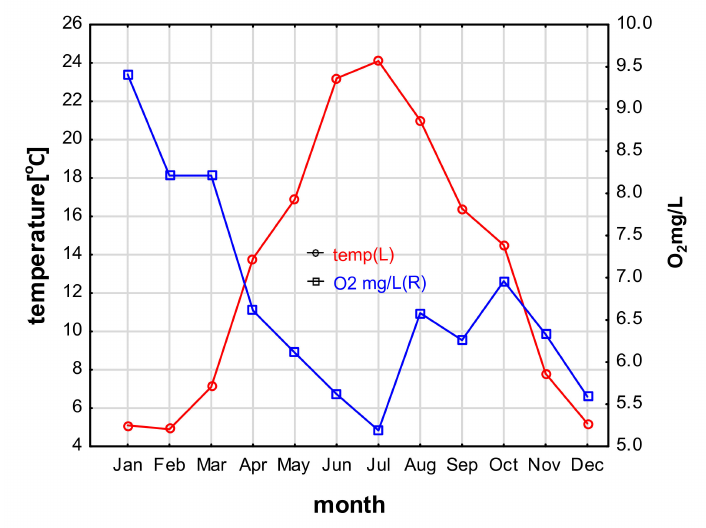
Figure 2. Temperature and oxygen content in the Wardynka river (Poland) in the years